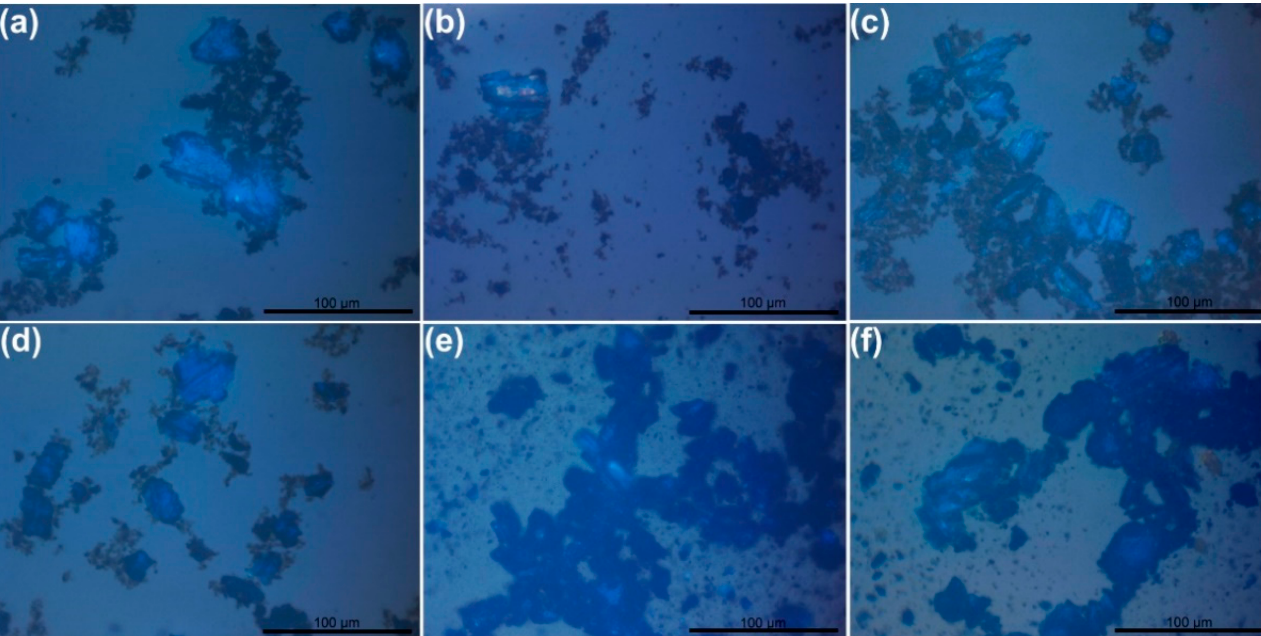
Figure 2. Optical micrographs of GBS obtained after 24 h from the start of the synthesis—A000 ( a ), A100 ( b ), P000 ( c ), P100 ( d ), C000 ( e ), and C100 ( f ).